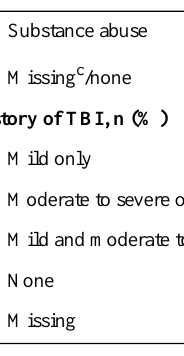
Table 2. App interaction data over the course of the study (approximately 90 days) are shown in Figure